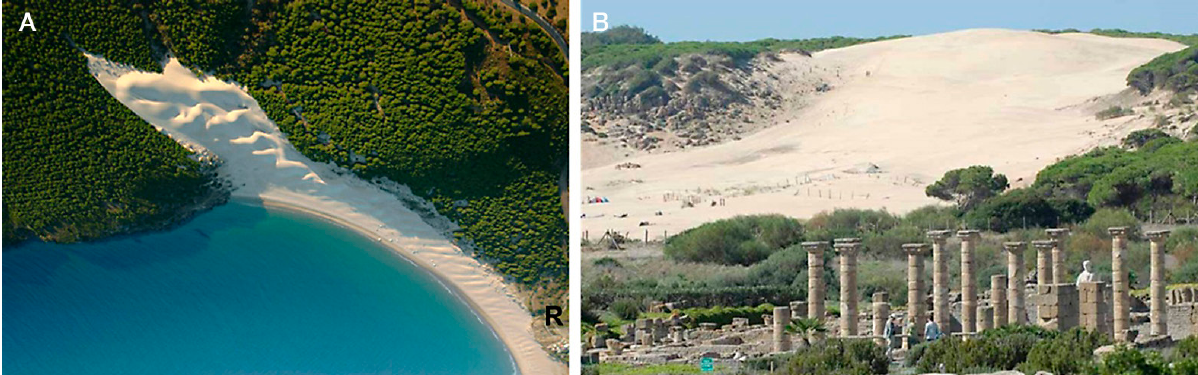
Fig. 3. – A, aerial view of Bolonia beach and dune with the Roman ruins in the right corner (point R). B, view of the Bolonia dunefield from the ruins of Baelo-Claudia.